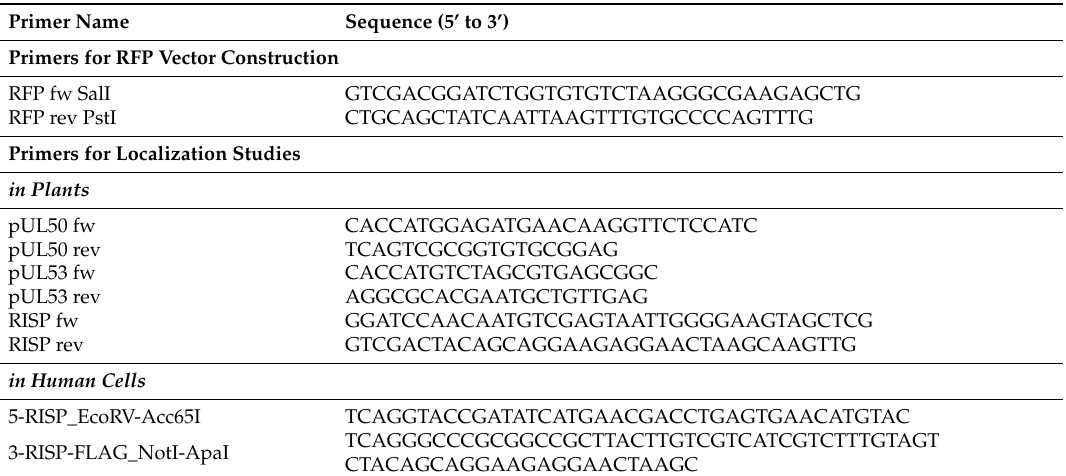
Table 1. Sequences of oligonucleotide primers used for